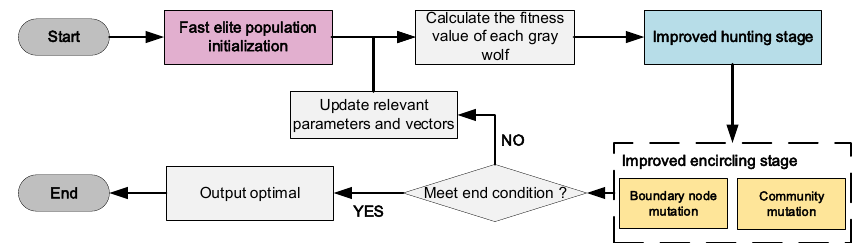
Figure 2. The framework of the